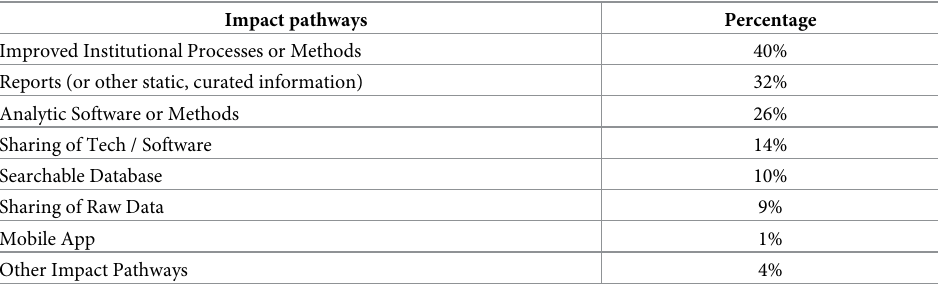
Table 6. Prevalence of impact development